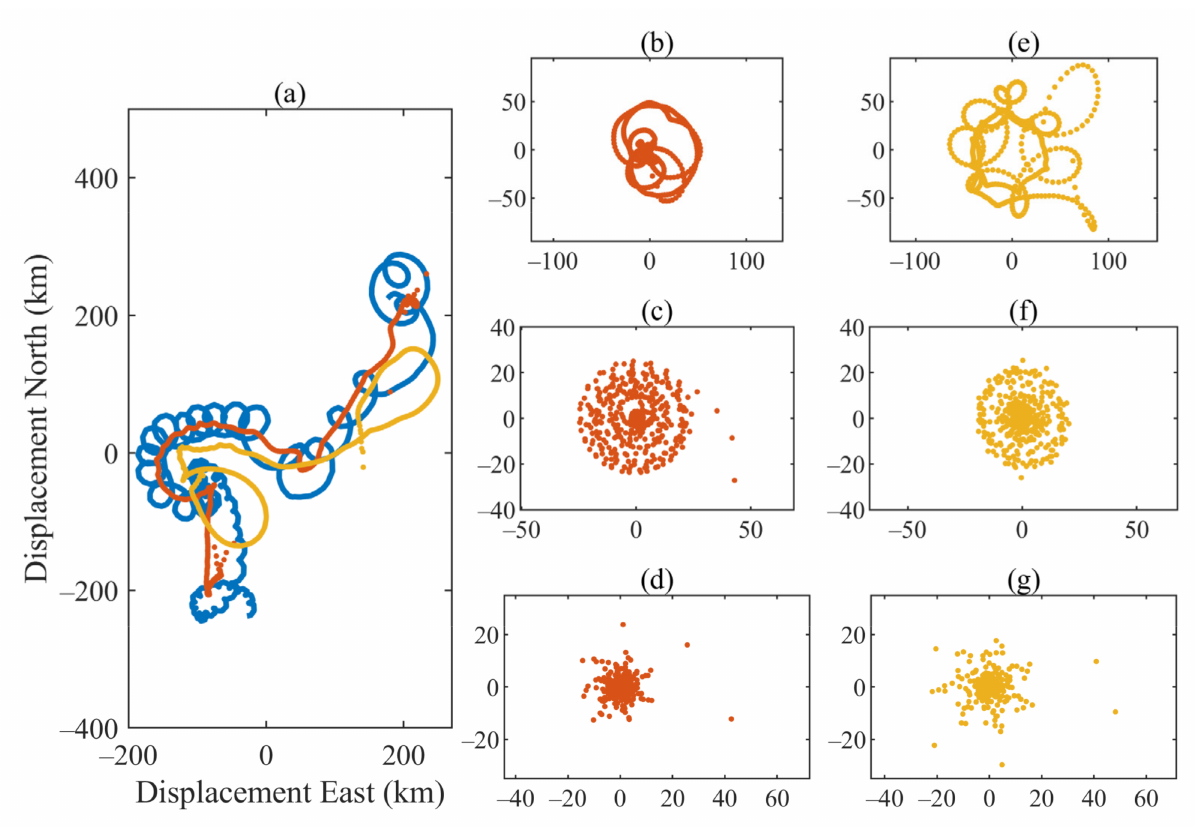
Figure 10. The trajectories of the original float data (blue solid line), its MCVMD results (red dotted line), and CVMD results (yellow dotted line): ( a ) original trace, MCVMD decomposed mode 1 and CVMD decomposed mode 1; ( b ) MCVMD decomposed mode 2,;( c ) MCVMD decomposed mode 3; ( d ) MCVMD decomposed mode 4; ( e ) CVMD decomposed mode 2; ( f ) CVMD decomposed mode 3; and ( g ) CVMD decomposed mode